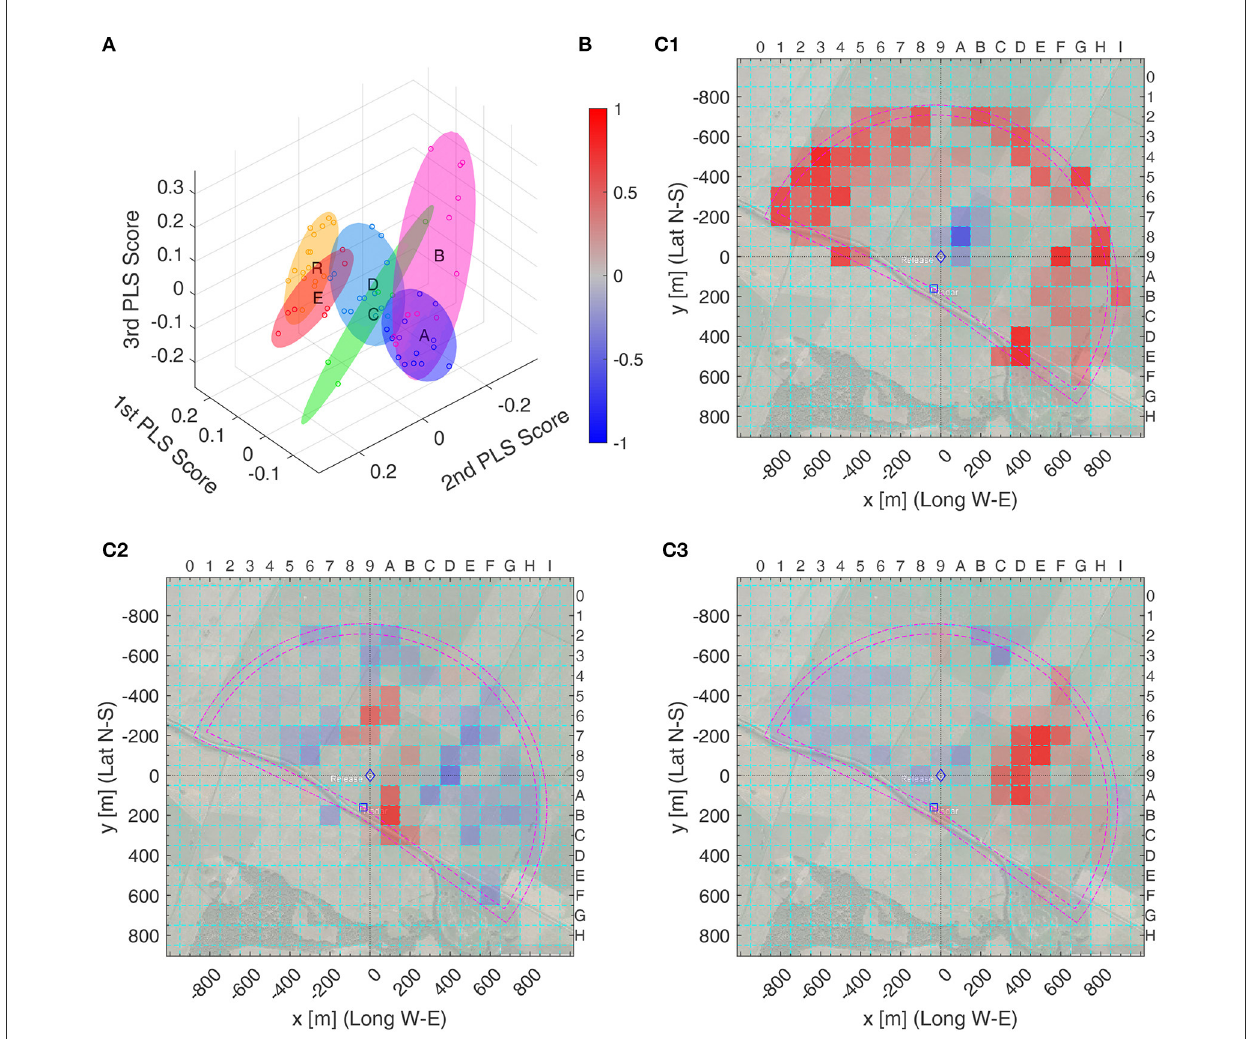
FIGURE6 PLS analysis of the heat maps of radar fixes of all test and model groups. (A) 3D plot of the top three PLS scores for each bee’s heat map (circles), together with minimum volume ellipsoids covering all PLS scores of one group. Color code of the ellipsoids and circles: A, B, C, D, E, and R. (B) Colorbar of the PLS support vectors values, normalized to the interval [ 1, 1], for (C1–C3) . (C1 – C3) Top three PLS support vectors, with color − + coding as in (B) : (C1) first, (C2) second, and (C3) third PLS support vector. Left and bottom label: distance from the release site, ♦ , in meter relative to the Release Site; top and right: x and y label of the spatial discretization boxes. For example, PLS Support Vector 1 is mostly positive (red) outside of the radar range (magenta half circles, inner one: true radar range, outer one: increased range due to smoothing filter) and all bees in Group S have a higher positive value for the corresponding PLS score than all other bees, see (A) , Thus, the bees in Group S spent a higher proportion of their time outside of the radar range than the bees A–E and R, as for them this time could not be